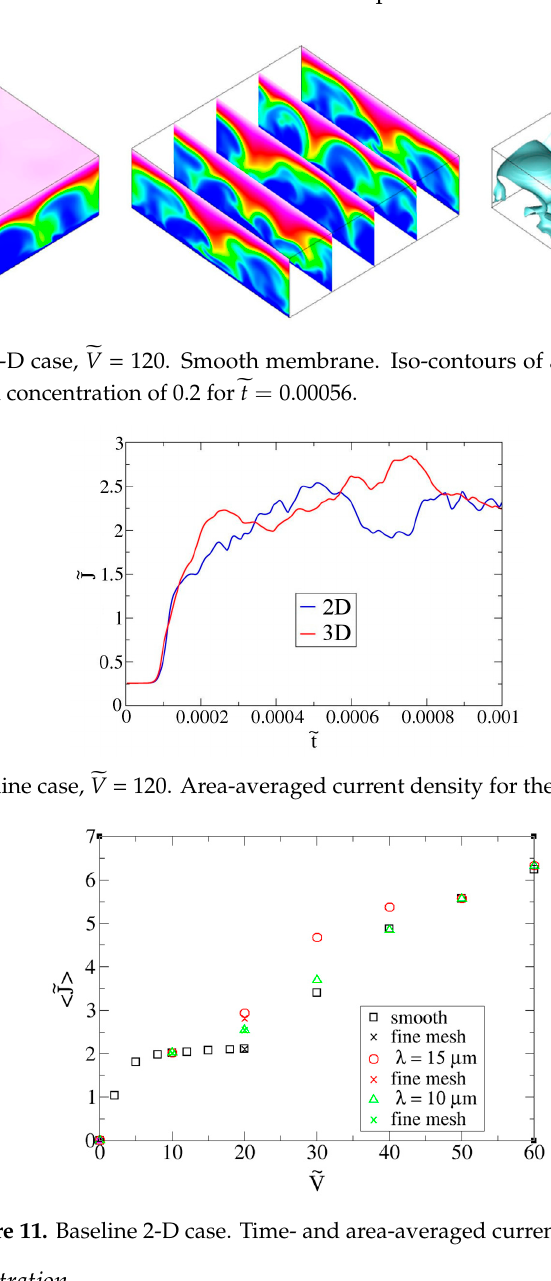
( c) Figure 12. Two-dimensional simulations for 𝑉 (cid:3556) = 120 and ( a ) 10 mol/m (cid:2871) , ( b ) 100 mol/m (cid:2871) , and ( c ) 400 mol/m (cid:2871) . Smooth membrane . Anion concentration. 4.3. Wavy Membrane The main emphasis of the present investigation is on the effect of surface roughness on the current density. According to Rubinstein and Zaltzman [8], by making the membrane surface wavy, the initial wavelength of the disturbances can be controlled. All simulations with wavy membrane are for the baseline case with a 1 mol/m (cid:2871) concentration. It was decided to first try a membrane waviness with an amplitude of 𝐴 = 0.5 μm and a wavelength of 𝜆 = 10 μm . Iso-contours of the anion concentration for a dimensionless voltage of 𝑉(cid:3560) = 120 are shown in Figure 13. Compared to the